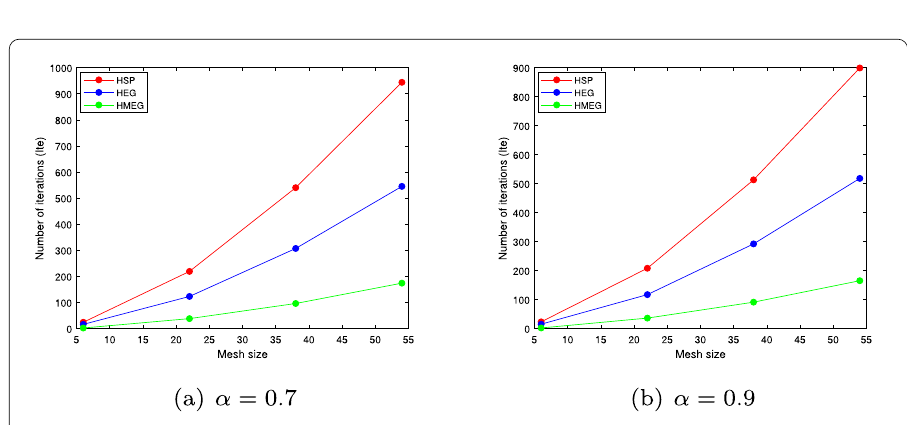
Figure 8 The iterations number plot of the HSP, HEG and HMEG methods for Example